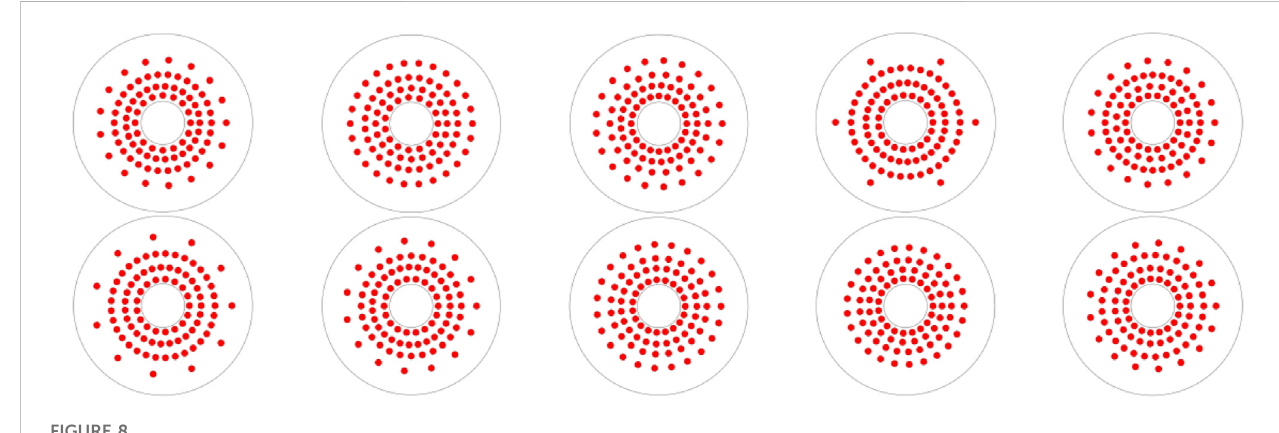
FIGURE 8 Optimal layout after NMC fi